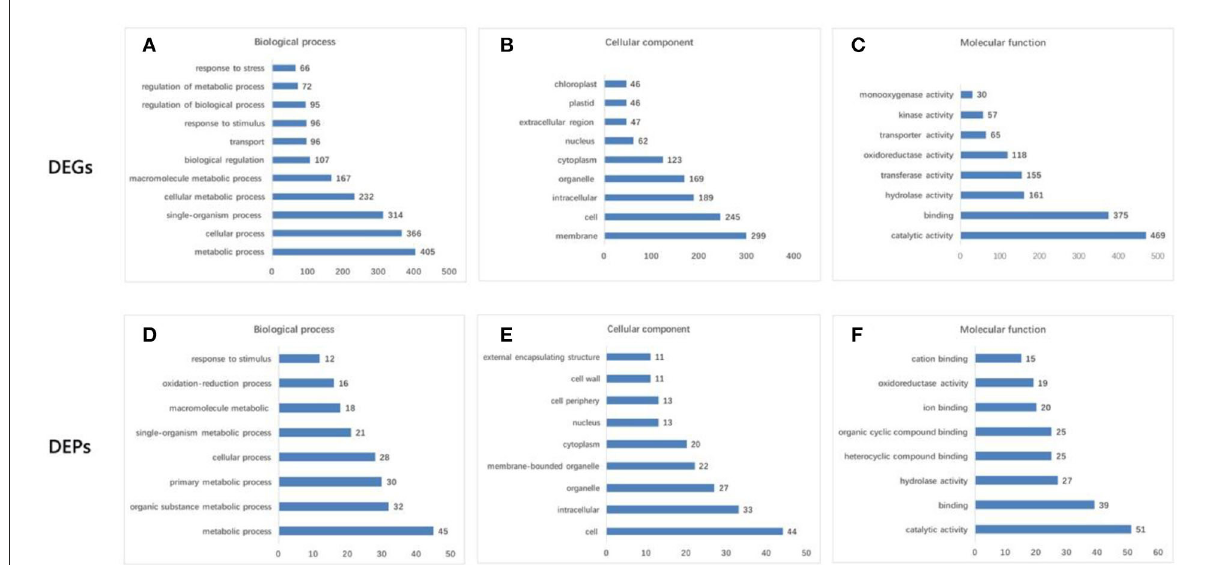
FIGURE2 GO functional analysis of differentially expressed genes (DEGs) and differentially abundant proteins (DAPs). (A,D) Biological process. (B,E) Cellular component. (C,F) Molecular function. DEGs were mainly enriched in “metabolic process” (405 DEGs) and “cellular process” (366) for the biological process; “membrane” (299) and “cell” (245) for the cellular component; and “catalytic activity” (469) and “binding” (375) for the molecular function. The transcriptome data were significantly enriched in several GO categories, such as “cell wall organization and biogenesis,” “defense response,” “response to hormone,” “gametophyte development,” “pollen development,” “pollen germination,” and “pollination,” which are pollen–style interaction-associated biological processes. Moreover, GO terms annotation of DAPs revealed that “cell” (44) and “intracellular” (33) were the major cellular components; “catalytic activity” (51) and “binding” (39) were the major molecular functions, and “metabolic process” (45) and “cellular process” (28) were the major biological processes.